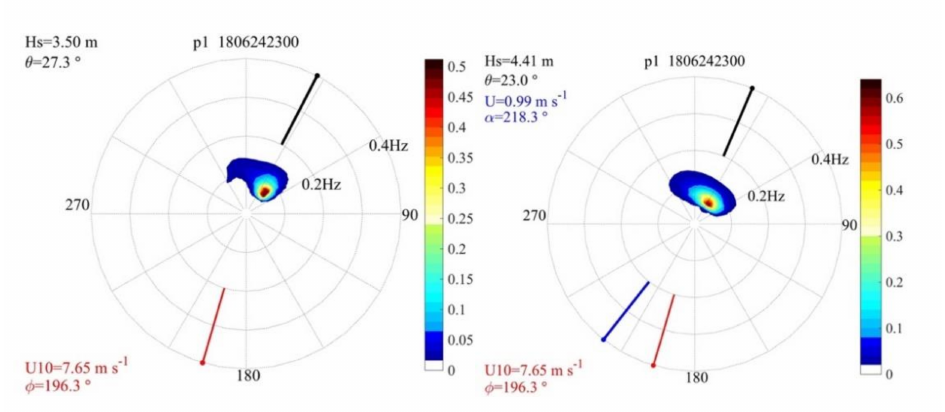
Figure 10. SWAN wave spectrum at P1 (31 ◦ E, 31 ◦ S) from the simulation considering only waves ( left ), affected by the current wave spectrum ( right ) (Velocity Current = 0.85 m/s) for the 24 June 2018 at 23 UTC. Symbols: ϕ (wind direction), θ (wave direction), α (current direction), U (Current velocity). The arrowhead (circle) points to where the waves and currents propagate (oceanographic convention).